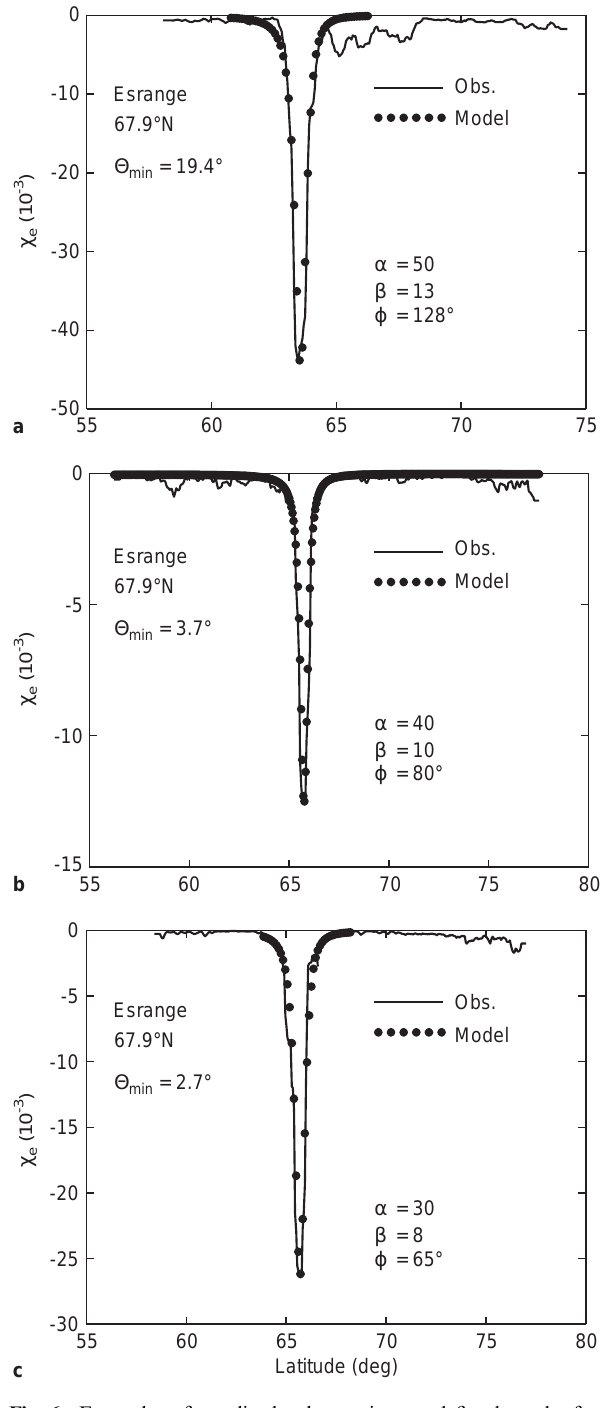
Fig. 6. Examples of amplitude observations and fitted results from three satellite passages at Esrange. The fitting is similar to that in the bottom panels of Figs. 4